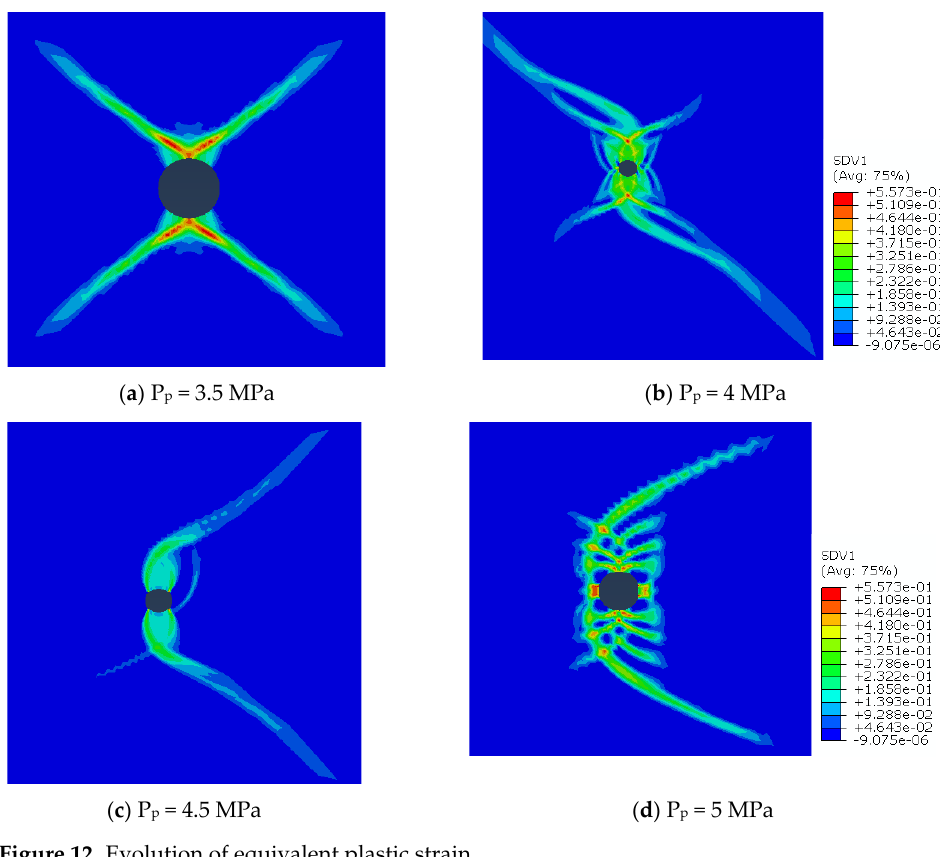
Figure 12. Evolution of equivalent plastic strain.